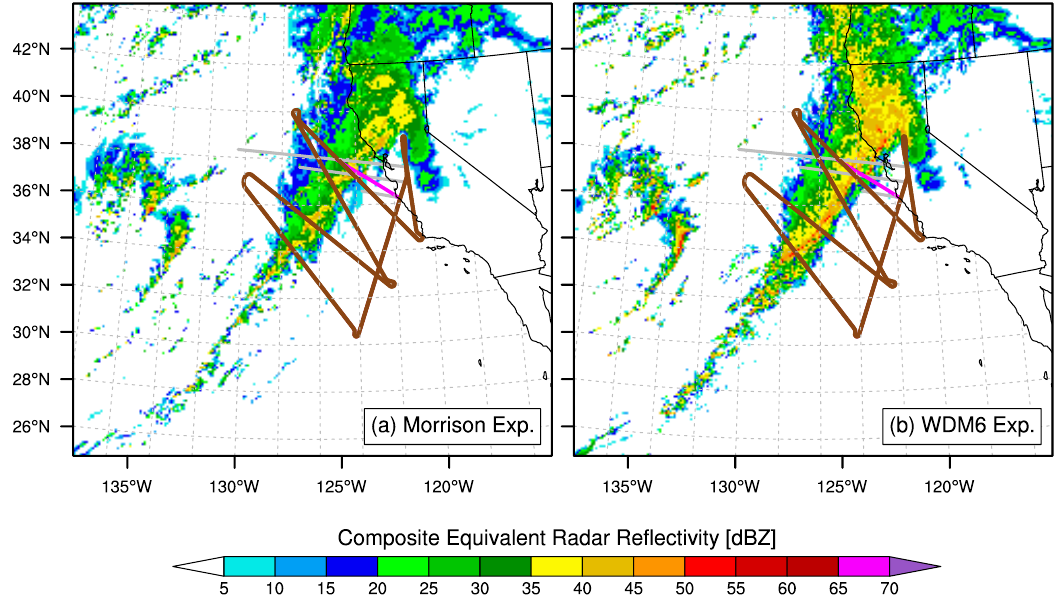
Figure 4. The composite (column maximum) equivalent radar reflectivity (shaded, dBZ) from the mesoscale model over the innermost domain and valid at 18:00 UTC 6 Feb 2015 for the ( a ) Morrison and ( b ) WDM6 experiments. The flight path (brown curve) is overlain along with the line connecting the tangent points of GPS occultation g03r (pink curve) and three of the ray paths from g03r (gray